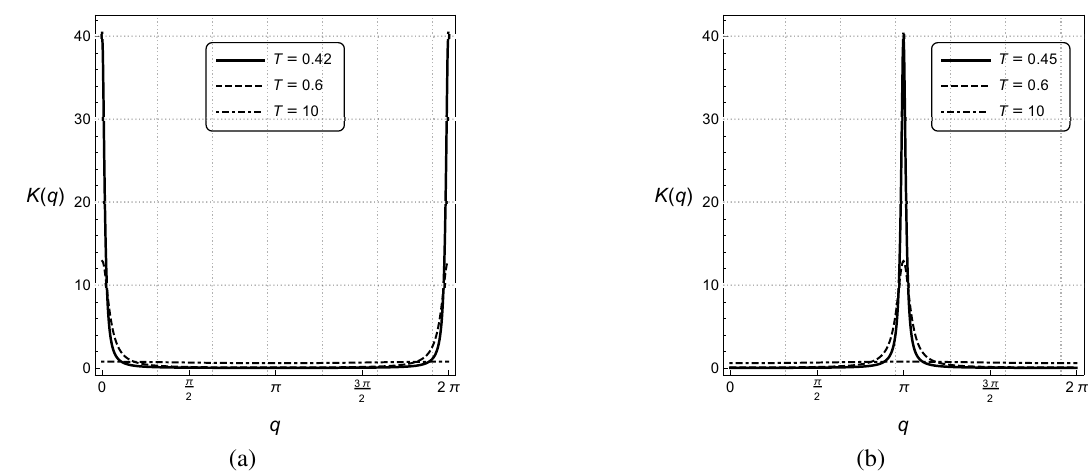
Figure 3. The dependence of the correlation function upon wave-vector q for the ferromagnetic ( J > 0) (a) and antiferromagnetic ( J < 0) interactions (b) in the one-dimensional Ising model with s = 1 at zero magnetic